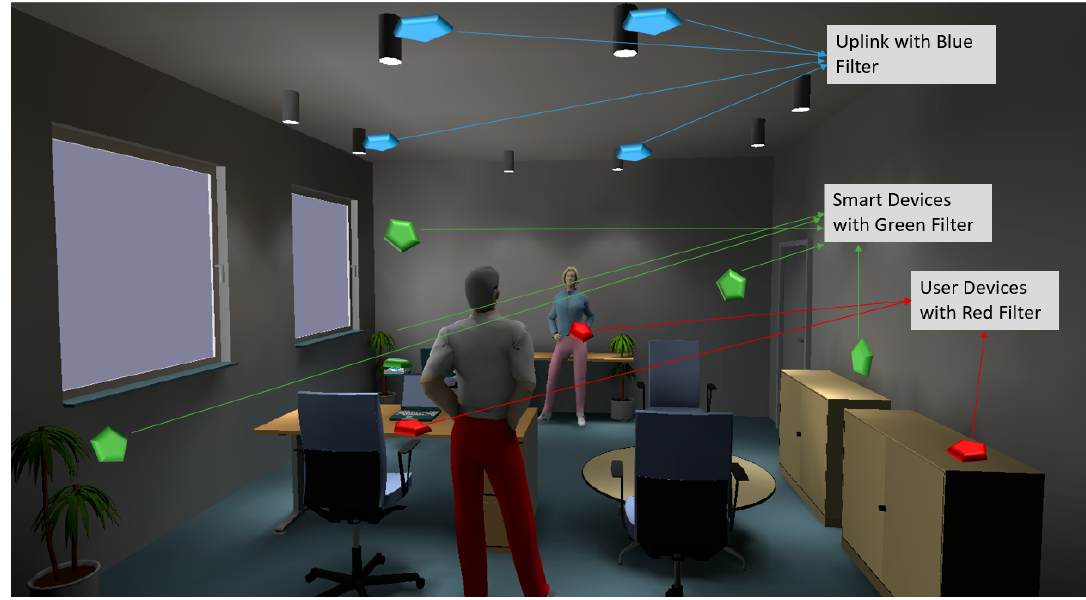
Figure 1. Proposed multi-user full-duplex visible light communication (VLC) system.